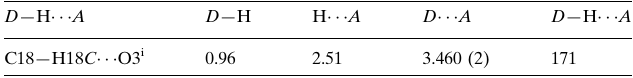
Hydrogen-bond geometry (A˚ , (cid:1)